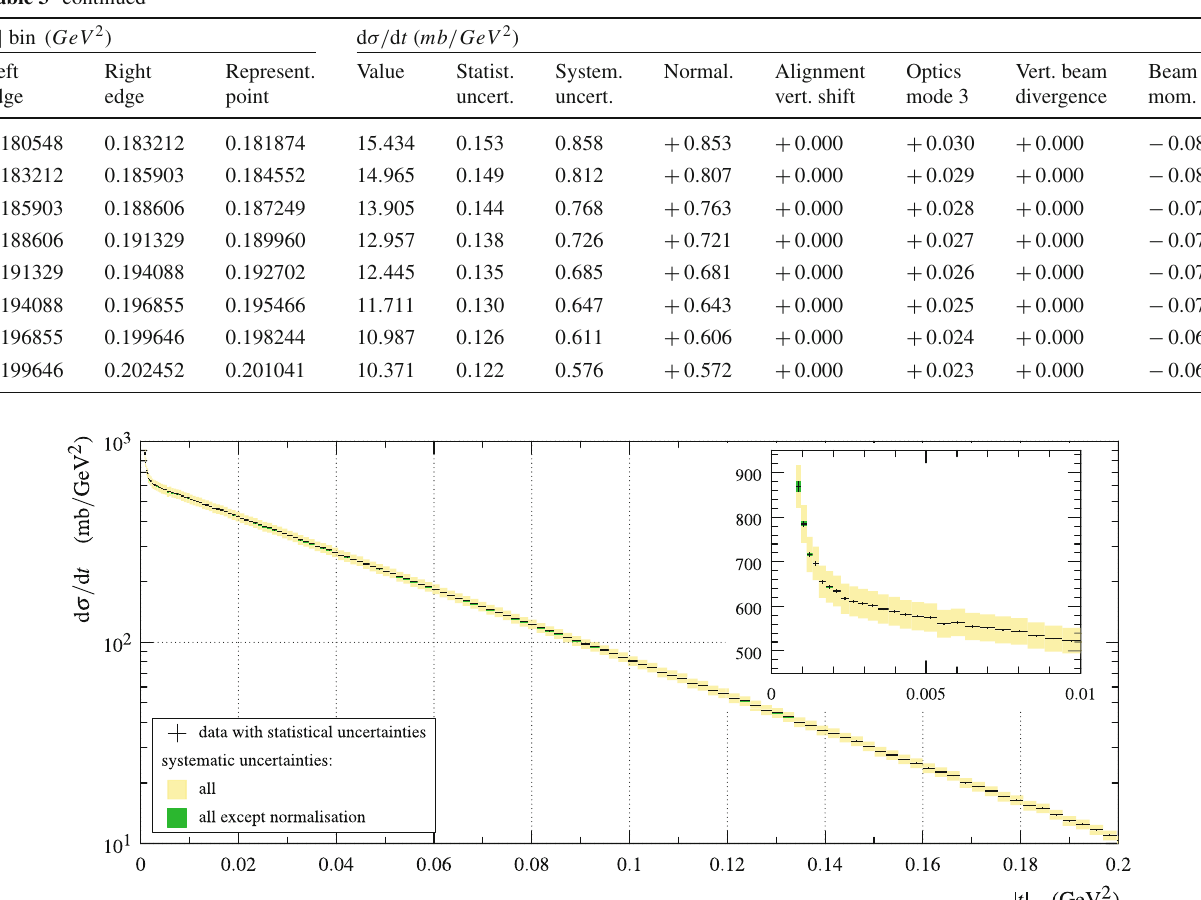
Fig. 10 Differential cross-section from Table 3 with statistical (bars) and systematic uncertainties (bands). The yellow band represents all systematic uncertainties, the green one all but normalisation. The bands